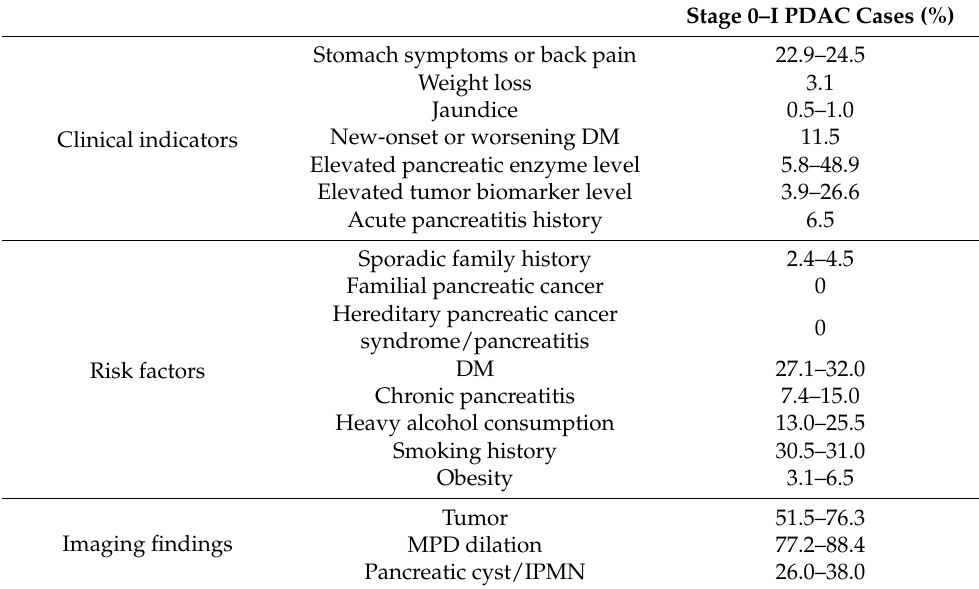
Table 1. Classification of and each rate of factors associated with PDAC detection: clinical indicators, risk factors, and indirect imaging